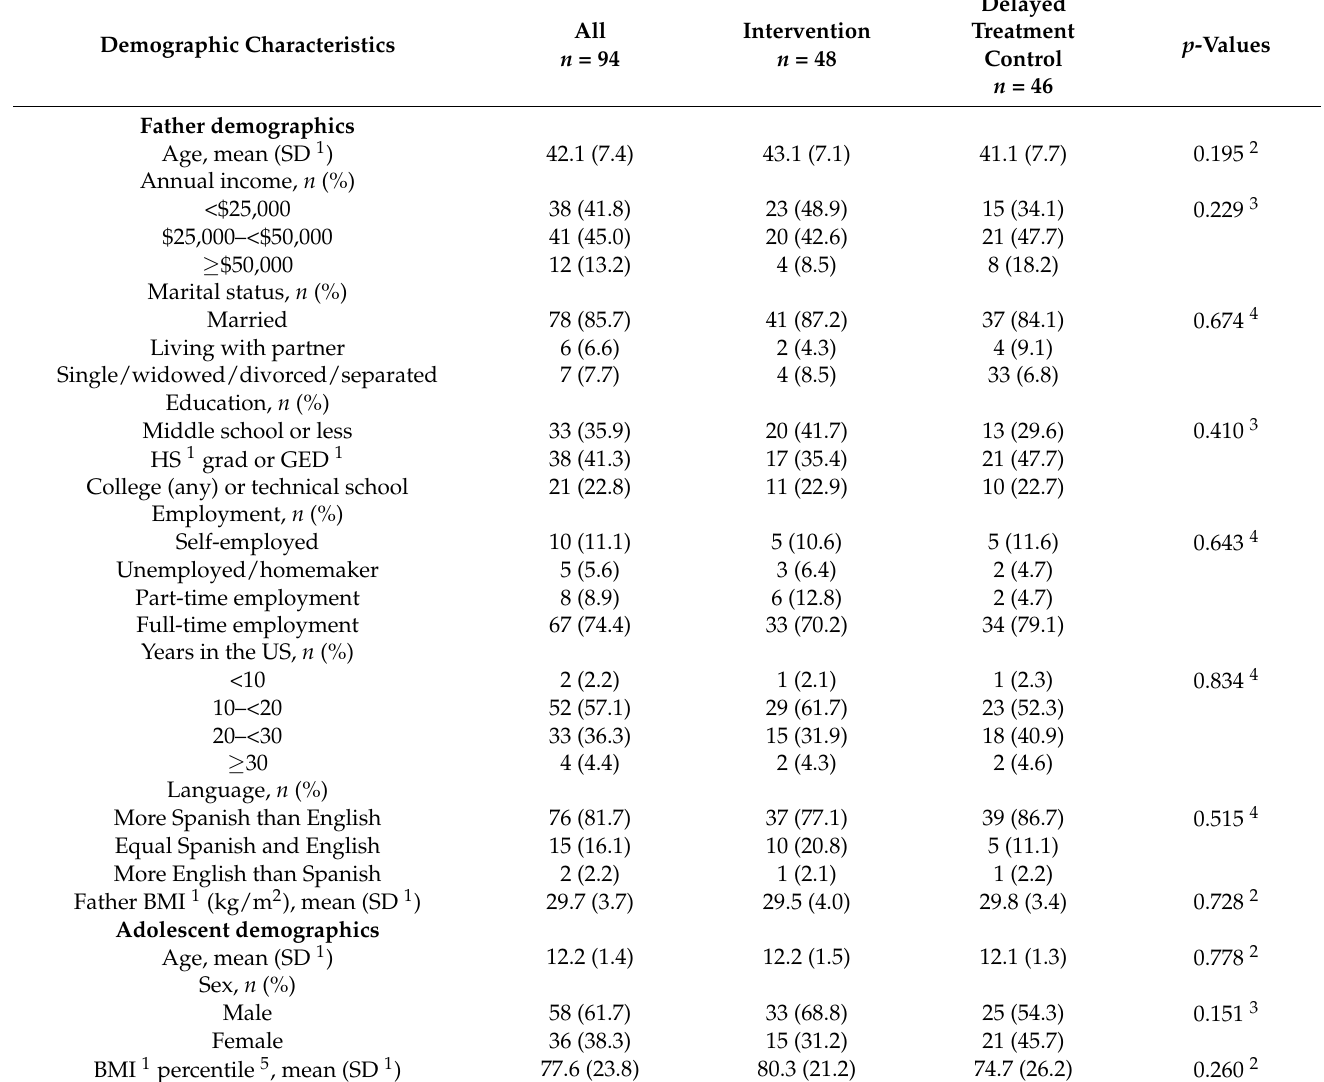
Table 1. Time-1 father and adolescent demographic characteristics ( n =